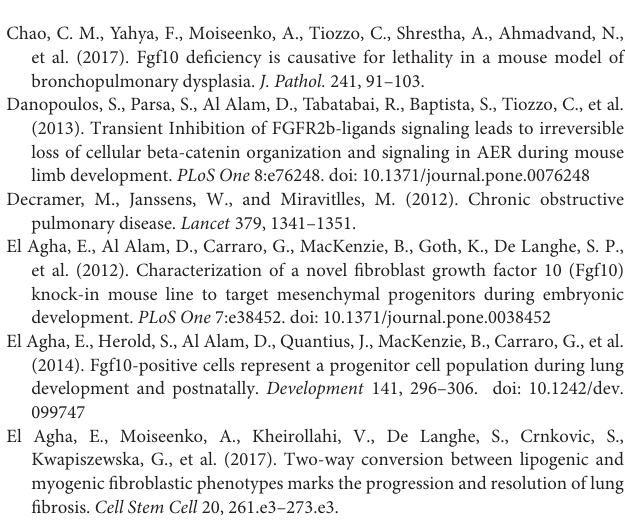
Supplementary Figure 1 | Comparative Fgf10 expression in Fgf10 + / + and determine Fgf10 expression. Supplementary Figure 2 | Co-expression of ACTA2 and tdTomato in FGF10 Pos cells. Fgf10 Ki − v 1 ; tdTomato flox / + pups received one injection of Tam subcutaneously at P2 and were analyzed at